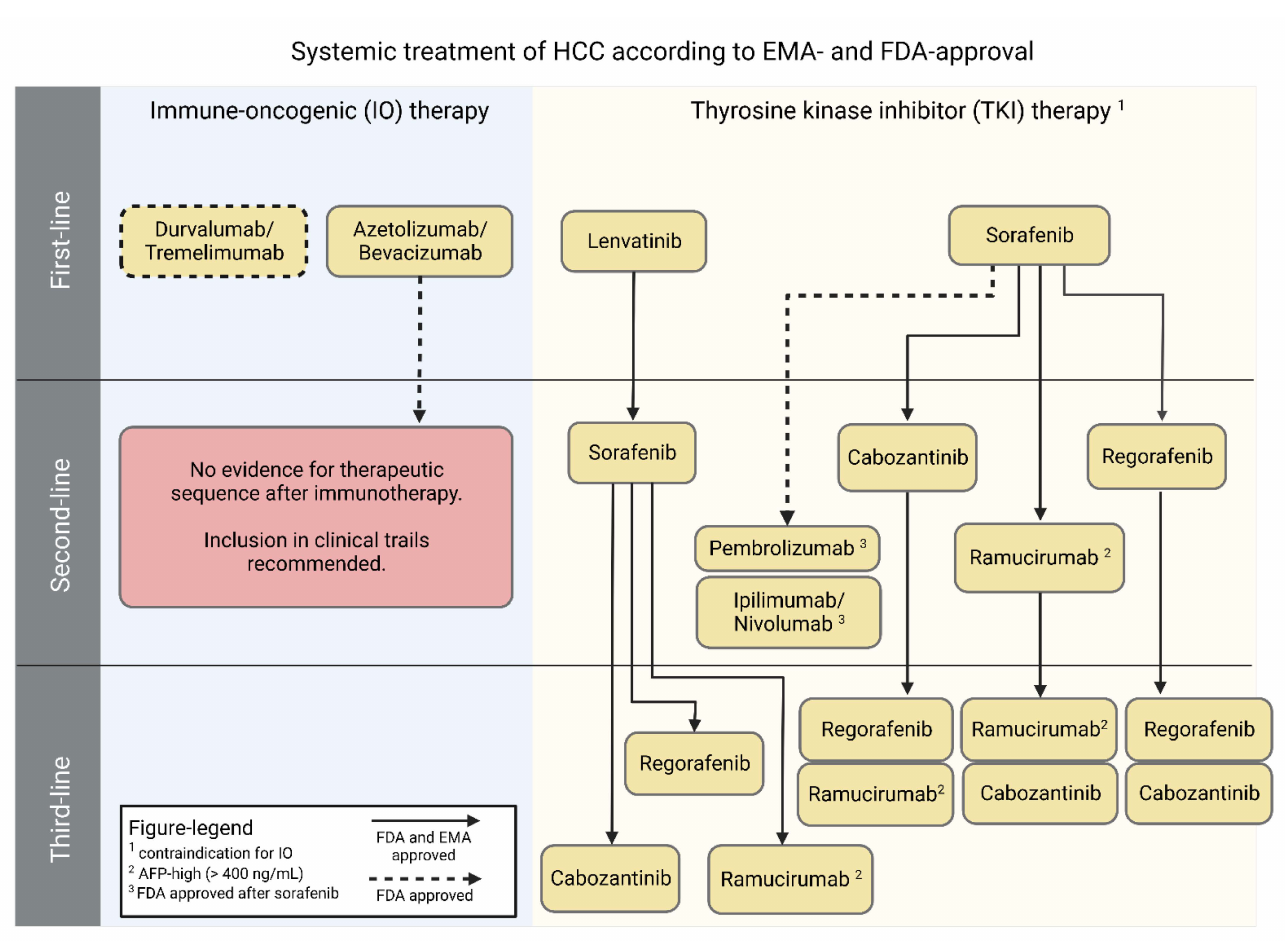
Figure 2. Algorithm of systemic therapy in HCC (BCLC stage C) based on approval by EMA and FDA. Scientific data supporting a therapy algorithm after 1st line therapy with Atezolizumab/ Bevacizumab is missing. Sorafenib is approved in the therapy of HCC regardless any other / previous therapy. Cabozantinib, ramucirumab and regorafenib are approved after previous therapy with sorafenib; Regorafenib for patients that has previously responded to sorafenib; Ramucirumab in patients with AFP-overexpressing tumors (AFP > 400